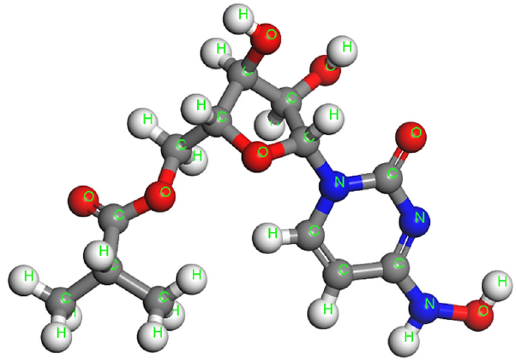
Figure 4. The optimized molecular structure of the molnupiravir.